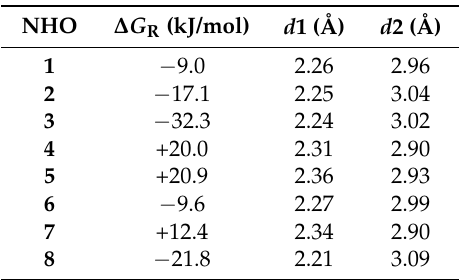
Table 2. Properties of the ZnCl 2 (NHO)(THF) complexes.